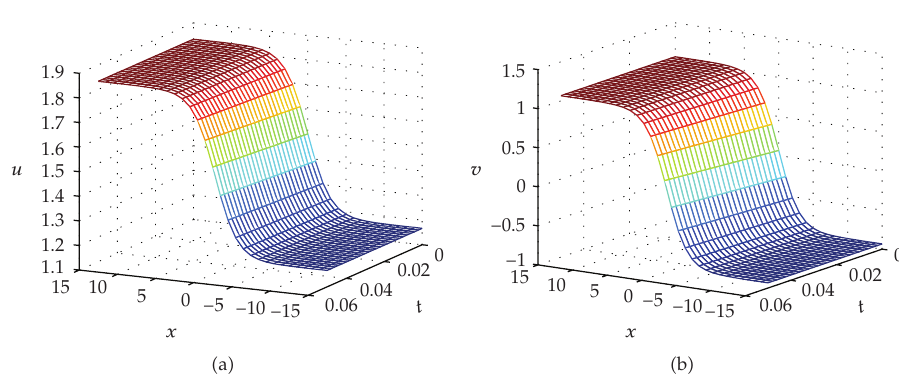
Figure 6: Explicit numerical solutions with h (cid:8) − 1, α (cid:8) β (cid:8) 1, λ (cid:8) 0 . 1, b (cid:8) 1, and k (cid:8) 1 / 3.